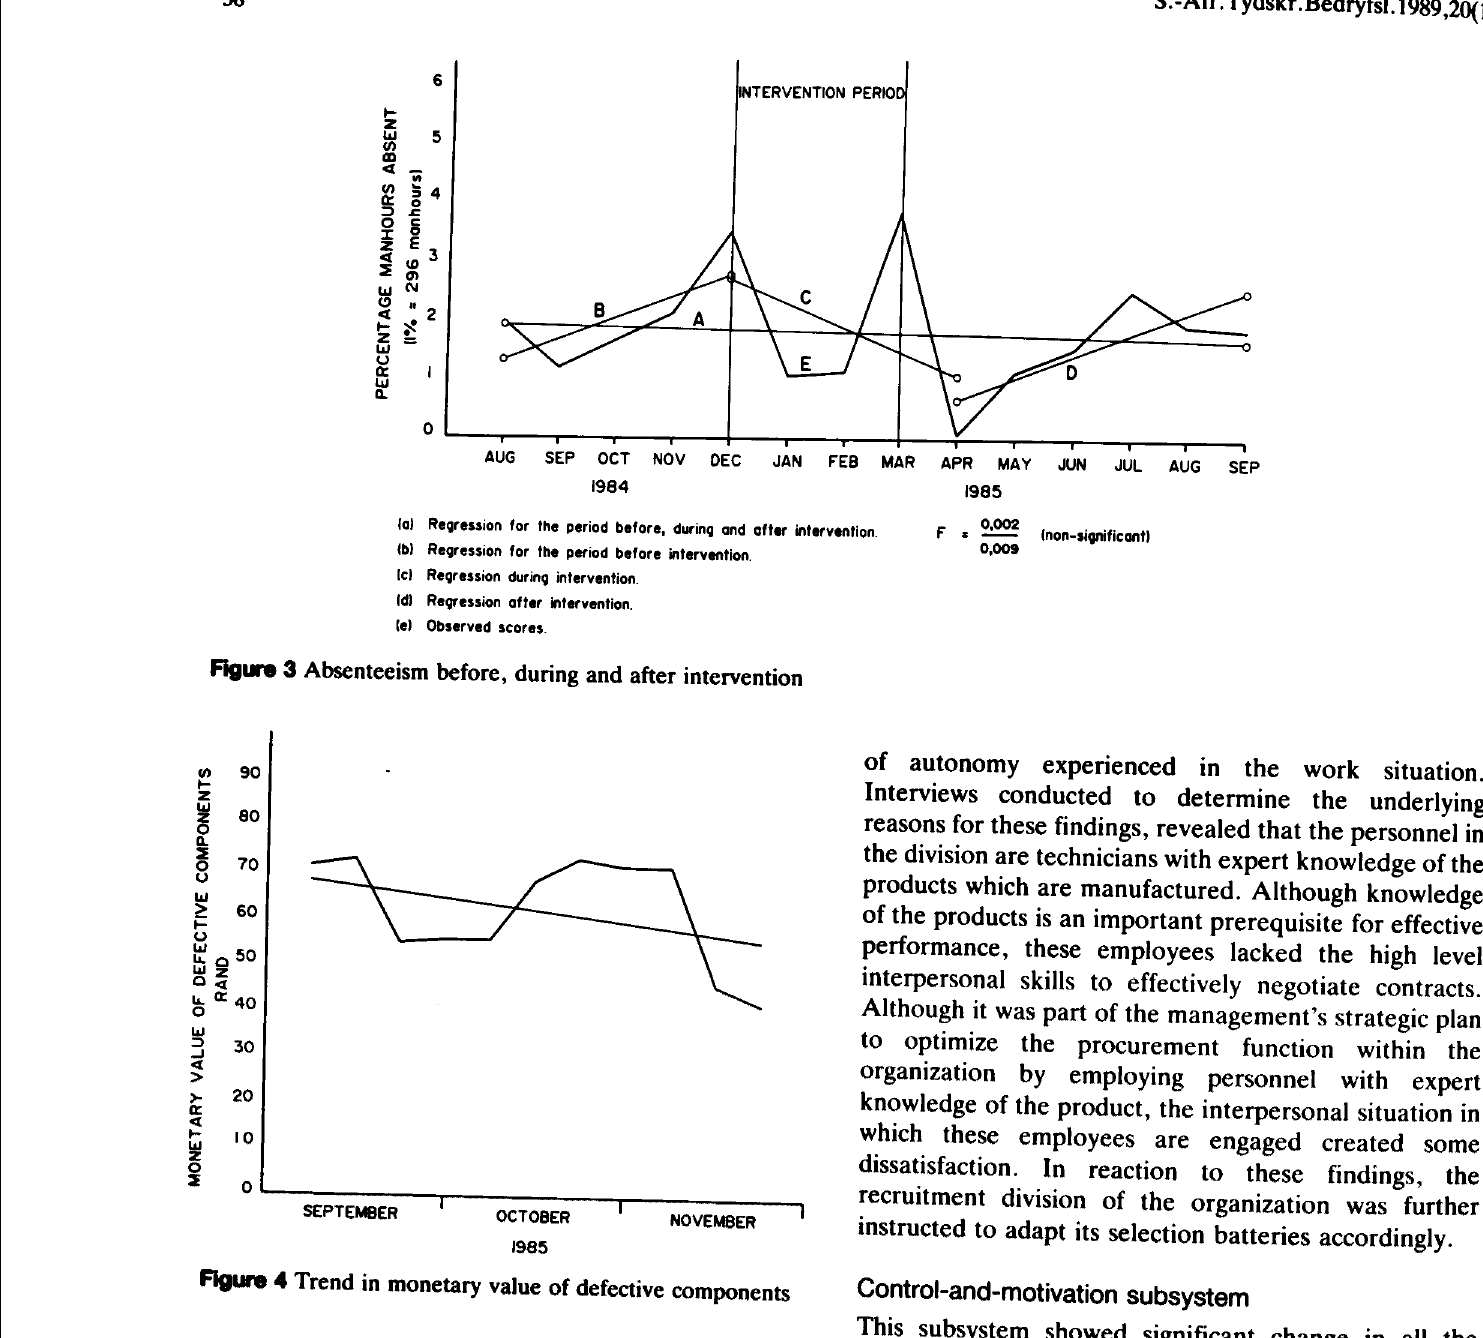
FigLWe 4 Trend in monetary value of defective components intervention phase. A small effect size was measured at the managerial level, whereas a medium effect was measured at the supervisory level. Although the work standards seem to be significantly more measurable only at the supervisory level, large effect sizes were measured at both levels. Although these results indicate positive change in the strategic subsystem, the priorities survey revealed that the communication of objectives did not significantly improve. After the intervention phase, the diagnostic survey showed that company policy was significantly clearer with a medium effect size at the worker